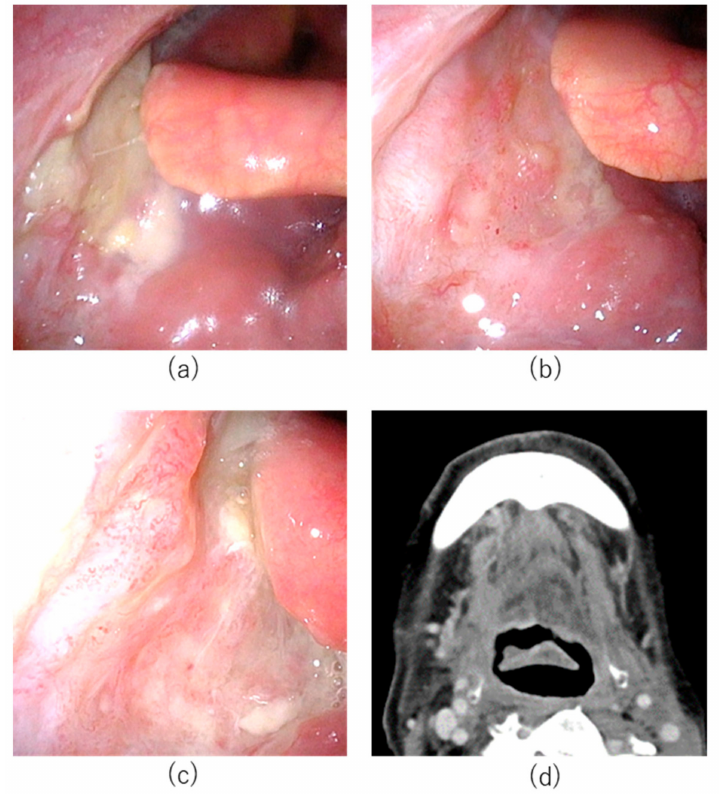
Figure 5. Posttreatment change after HN-ALX for Case 2. ( a ) Endoscopic image on postoperative day 21 after cycle 1. White coating was observed on the illuminated area. ( b ) Endoscopic image on postoperative day 98 after cycle 1. The mucosa was almost normalized with no obvious tumor. ( c ) Endoscopic image 11 months after cycle 2. The mucosal surface was slightly irregular. Biopsy did not detect evidence of cancer. ( d ) CT image 11 months after cycle 2. No tumor mass was